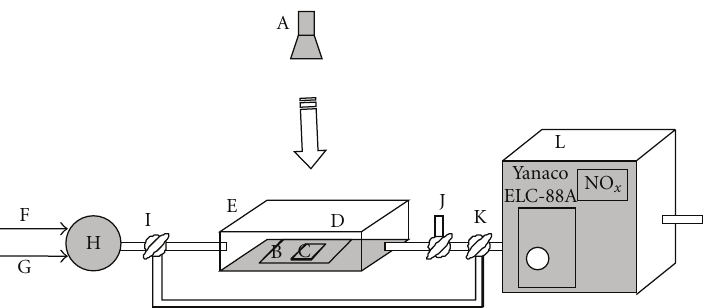
Figure 2: Photocatalytic reaction apparatus, A: LED lamp ( λ = 627,530,445, and 390 nm), B: glass holder, C: catalyst (20 × 16 × 0.5 mm), D: colorless and transparent quartz cover, E: sealed opaque reactor (plastic, 373 cm 3 ), F: 2ppm standard NO gas (flow rate: 100 mL/min), G: dried air (flow rate: 100 mL/min), H: gas mixer, I, J, K: three-way cock, L: NO x analyzer (Yanaco, ECL-88A).